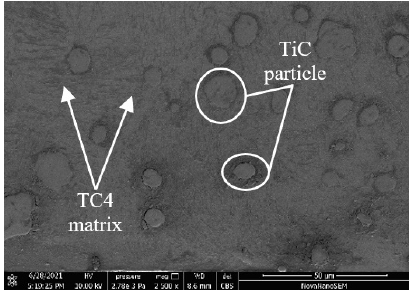
Figure 1. Scanning electron microscope images of 5% forged TiC p /TC4 composites.